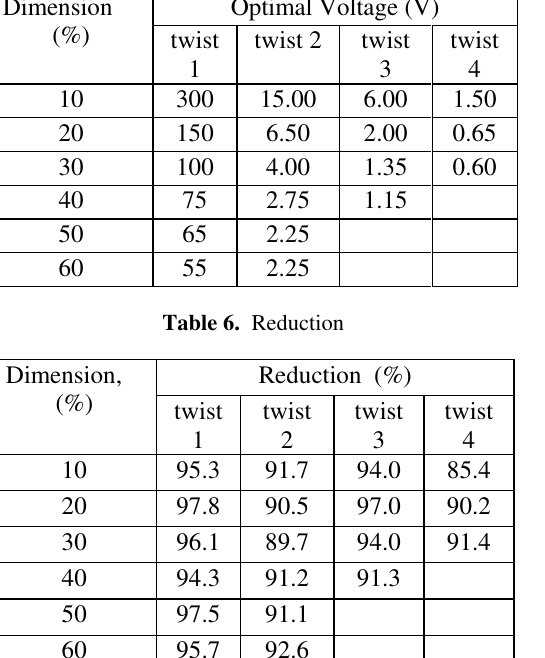
Table 5. Optimal Voltage